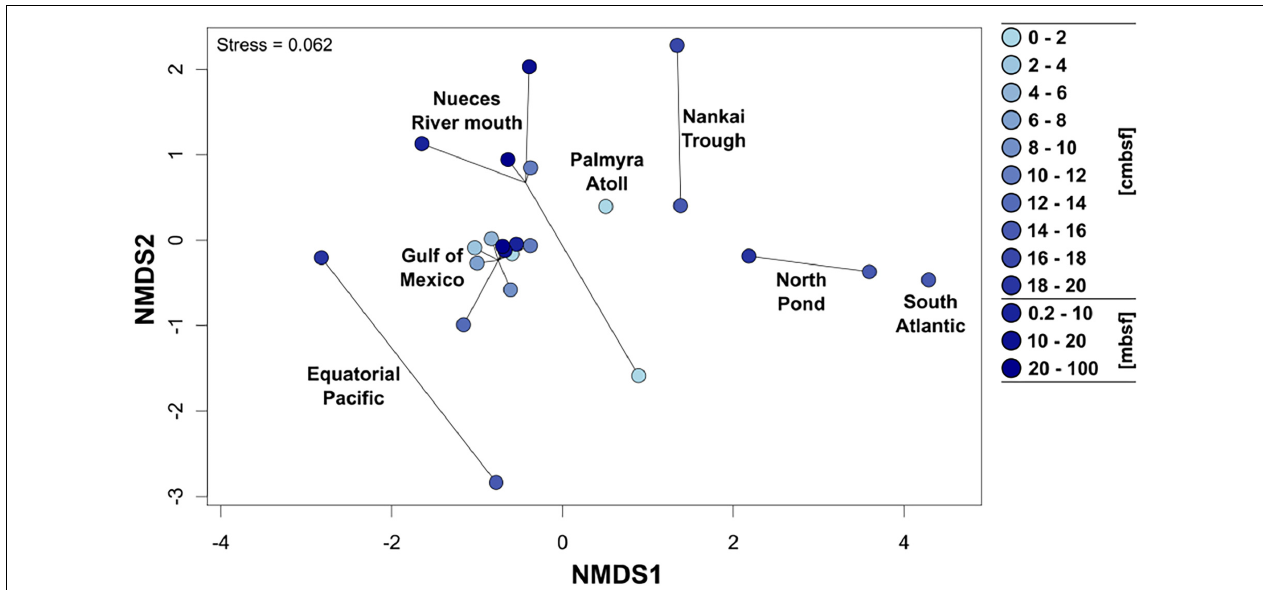
FIGURE 4 | Non-metric multidimensional scaling plot (NMDS based on Bray–Curtis distances) of the active Rhodobacteraceae community compositions based on the different sampling sites. Cycles show the community compositions at the specific site and the color of the cycles indicates increasing sediment depths (light blue: surface, dark blue: down to 100 m below